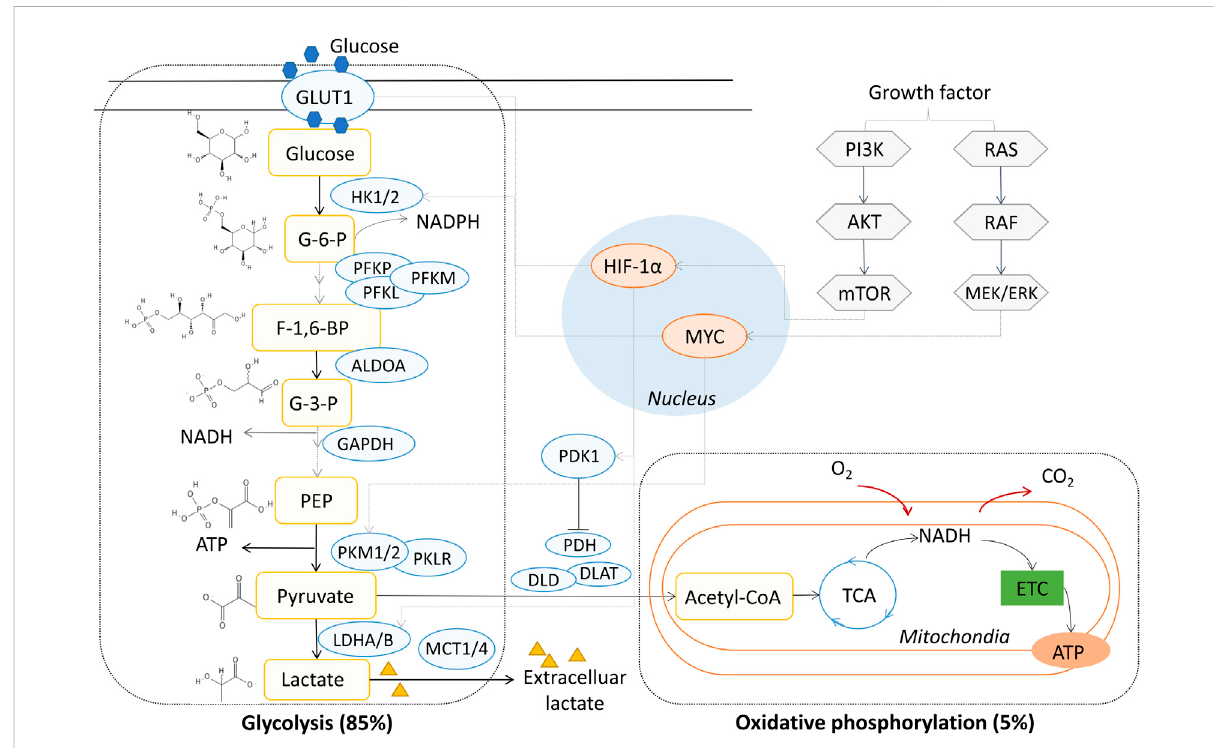
FIGURE 1 AerobicglycolysisinNSCLC.GLUT1,glucosetransporter1;HK,hexokinase;PFKL,phosphofructokinase,livertype;PFKM,phosphofructokinase, muscle type; PFKP, phosphofructokinase, platelet type; PKM2, pyruvate kinase M2; PKM1, muscle isoform pyruvate kinase M1; PKLR, red cell/liver pyruvate kinase; LDH, lactate dehydrogenase; MCT1-4, monocarboxylate transporter 1-4; PDK1, pyruvate dehydrogenase kinase 1; PDH, pyruvate dehydrogenase; DLD, dihydrolipoamide dehydrogenase; DLAT, dihydrolipoamide acetyltransferase; ATP, adenosine triphosphate; NADH, nicotinamide adenine dinucleotide; PI3K, phosphoinositide 3-kinase; TCA, tricarboxylic acid; ETC, electron transfer chain; MYC, MYC proto- oncogene; HIF-1 α , hypoxia-inducible transcription factor-1 alpha; G-6-P, glucose 6-phosphate; F-1,6-BP, fructose 1,6-phosphate; G-3-P, glyceraldehyde 3-phosphate; PEP,